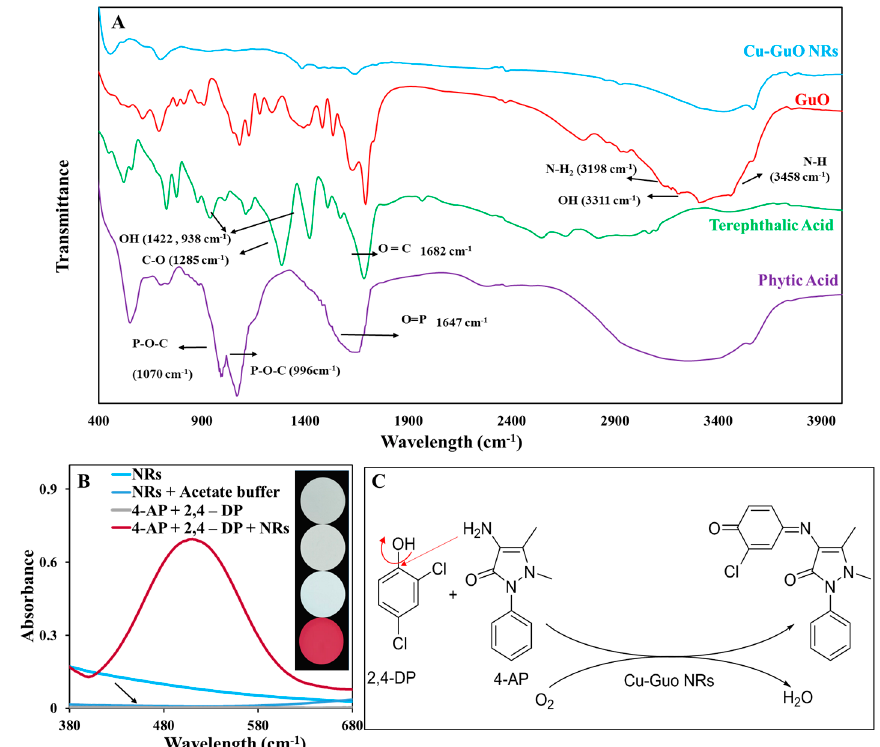
Figure 2. ( A ) FTIR spectra of phytic acid, terephthalic acid, Guo, and Cu − Guo NRs. ( B ) The absorbance spectra of NRs, the mixture of NRs and acetate bu ff er, and 2,4 − DP and 4 − AP in the absence and presence of NRs nanozyme with their corresponding images, and ( C ) a proposed reaction mechanism of 2,4 − DP and 4 − AP catalyzed by Cu − Guo NRs nanozyme.